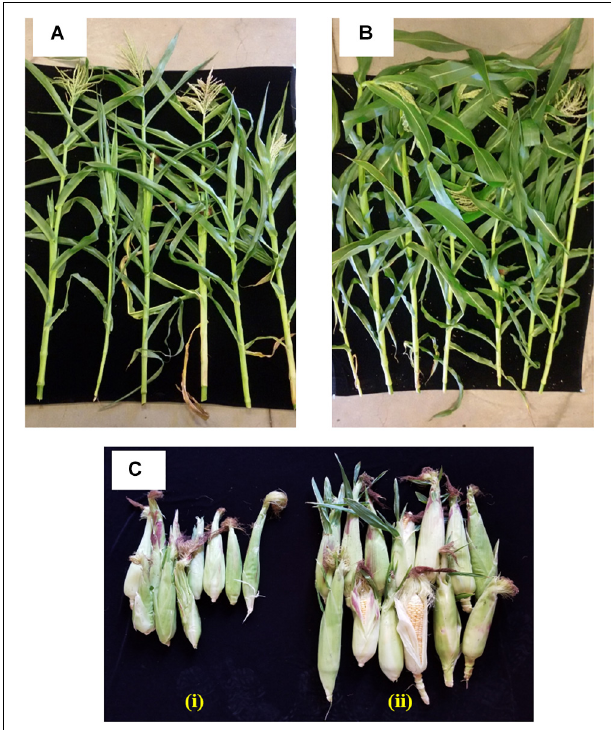
FIGURE 3 | Impact of D. cinnamea 55 on the growth of corn (outside garden trial). (A,B) Show representative plants randomly chosen from the uninoculated control and D. cinnamea 55 treatment, respectively. (C-i,ii) , Harvest of control and treated plants, respectively.